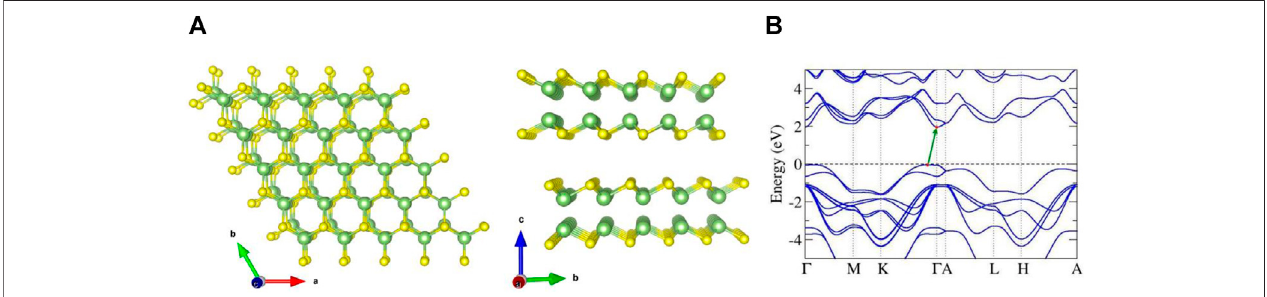
FIGURE 1 | (A) The atomic structural models for GaS thin fi lms. Green and yellow dots correspond to Ga and S atom, respectively. (For interpretation of the referencestocolorinthis fi gurelegend,thereader isreferredtotheWebversionofthisarticle). (B) Bandstructureofbulk β -GaScalculatedbyDFTsimulation.Thegreen arrow indicates the indirect band gap.